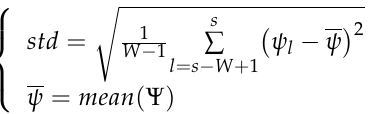
Figure 3. Position errors caused by the corrections of original Heuristic Drift Elimination (HDE) method for: ( a ) a straight path along a non-dominant direction; ( b ) a circular path.